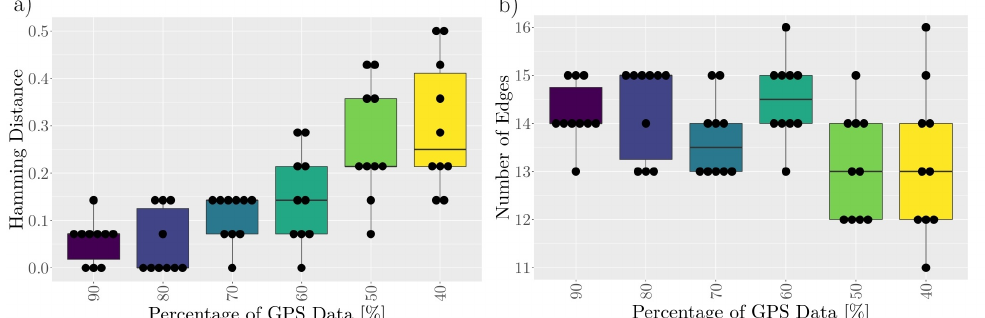
Figure 8. Robustness of the APC procedure applied for social network construction to the loss of GPS data. Randomly, fractions of data were removed in a way that only 90%, 80%, 70%, 60%, 50%, or 40% of the original data remained for network construction. This was done ten times per fraction. Afterwards, the constructed networks based on the incomplete data were compared to that of the original GPS dataset by using ( a ) the Hamming distance and ( b ) the number of edges. The original network consisted of 15 edges. In all networks, the number of nodes remained at eight. A Hamming distance of 0 indicates identical networks; a Hamming distance of 0.5 indicates 7 different edges (exchanged/newly present/absent).